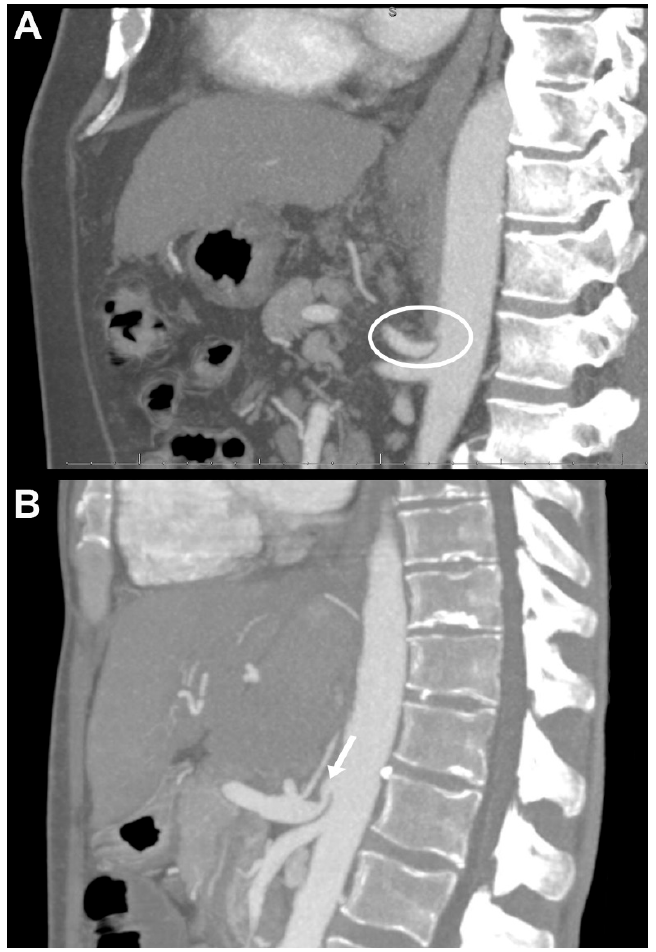
Figure 1. Preoperative computer tomography images of liver transplant recipients with median arcuate ligament compression (MALC) in the sagittal plane using maximal intensity projection. ( A ) Patient with severe median arcuate ligament (MAL) related occlusion. Note the hypertrophic MAL and the lack of continuous contrast in the celiac axis (circle). No calcified plaques were observed. Arterial revascularization was performed using an aorto-hepatic jump graft. ( B ) Patient with MALC. Note the hooked-like appearance of the celiac axis and the post-stenotic dilatation (arrow). MALC was released intraoperatively and standard branch-patch reconstruction could be performed with good outcome and without arterial complications.